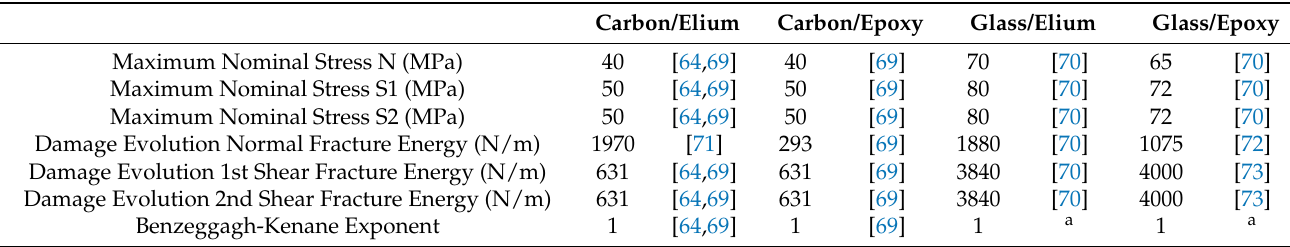
Table 3. Cohesive contact zone interface properties used in the